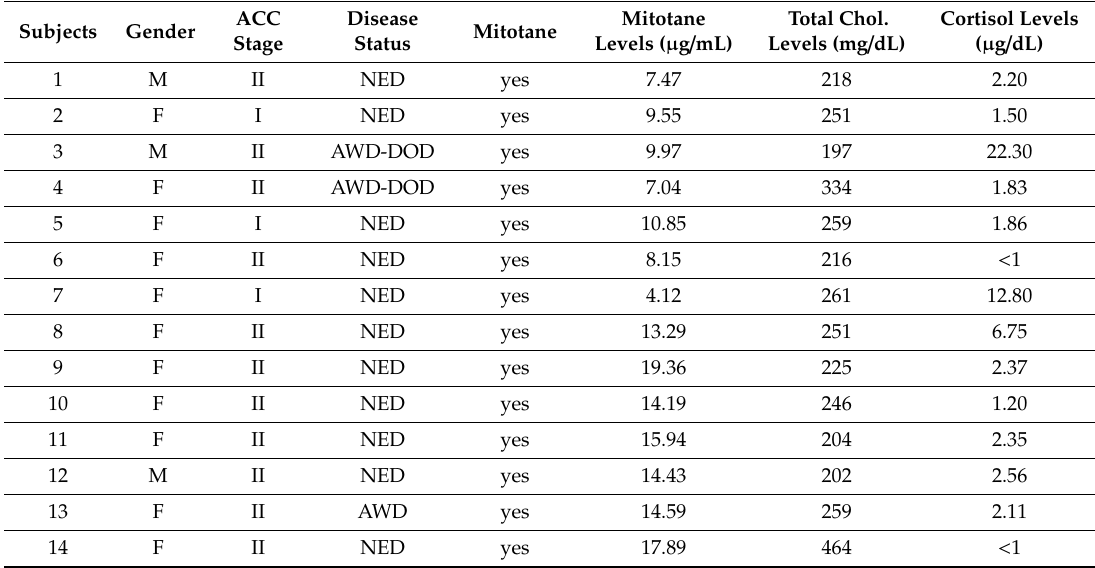
Table 1. Clinical features of adrenocortical carcinoma (ACC)